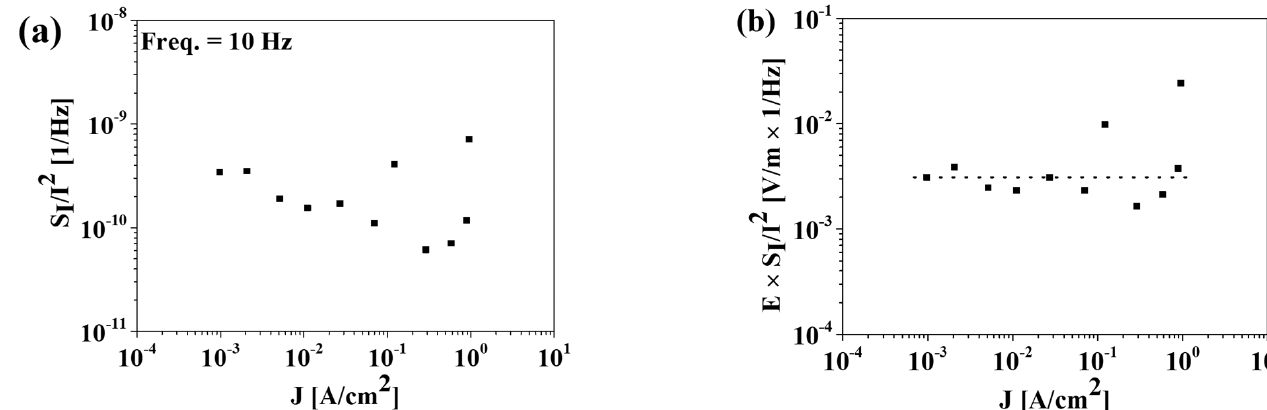
Figure 4. ( a ) ln (I/V) versus V 0.5 and ( b ) ln (I/V 2 ) versus 1/V show the Poole–Frenkel emission and the Fowler–Nordheim emission, respectively. From the straight lines, the dominant leakage mechanisms are the Poole–Frenkel mechanism from 0.7 to 3.2 V and the Fowler–Nordheim mechanism at V > 2.5 V.